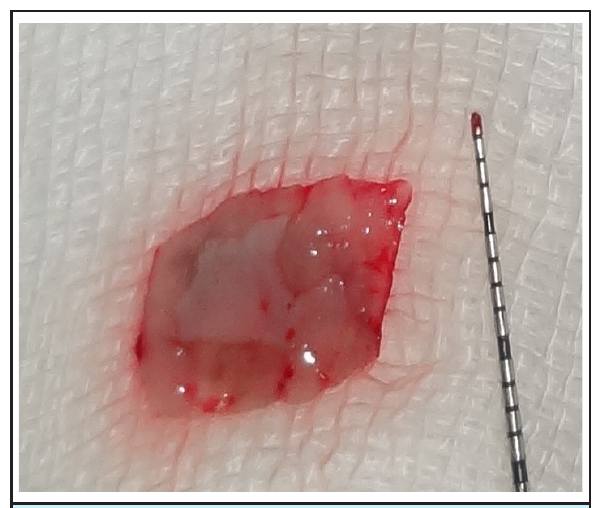
Figure 3. Soft tissue mass excised from anterior palate.